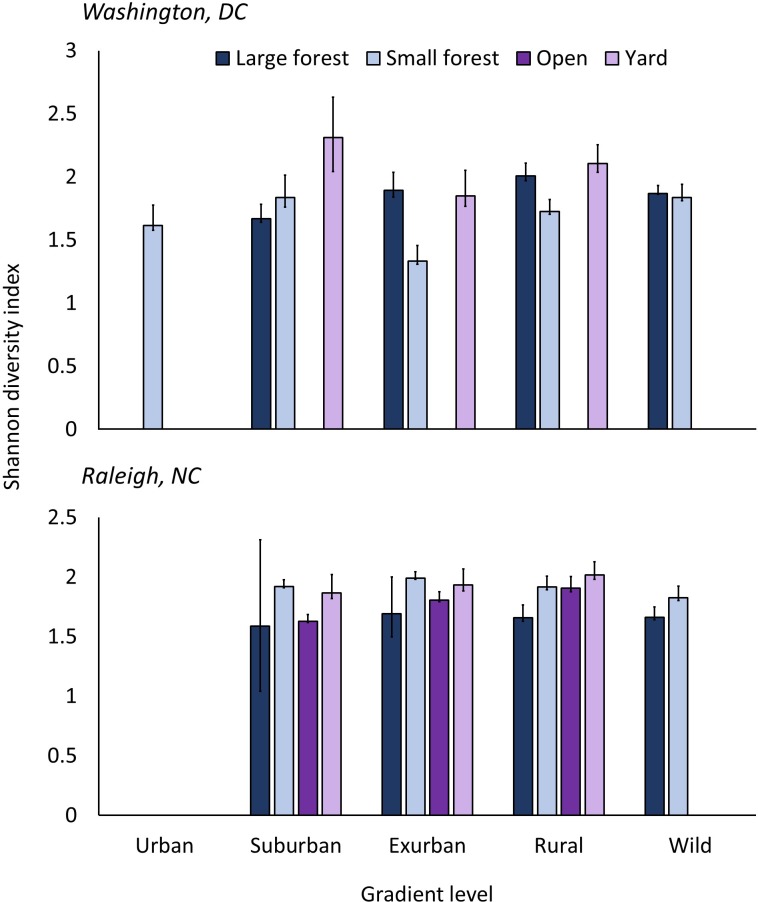
Shannon diversity index estimates from camera trapping in two cities, Washington, DC and Raleigh, NC, USA, across five development levels (urban, suburban, exurban, rural, wild).Diversity is separated by four plot types: large forest, small forest, open and residential yard. Data were collected using camera traps between 2012 and 2016. Bars show 95% confidence intervals. Urban small forests were not sampled in Raleigh, open areas were not sampled in DC and urban/wild yards, urban open areas and urban large forests were not sampled in either city.